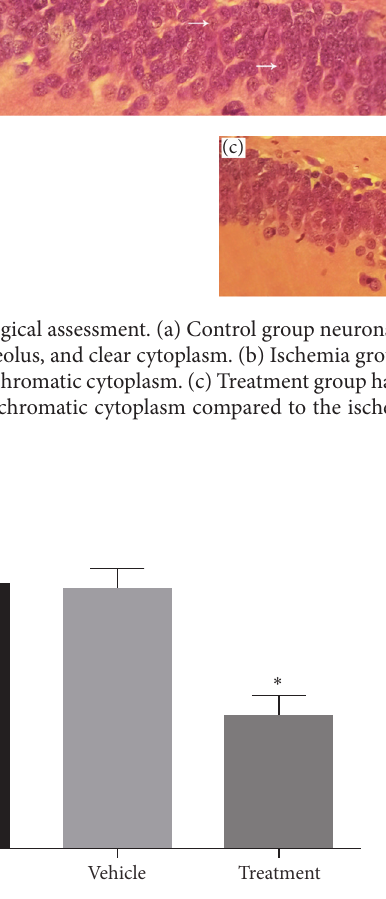
Figure 7: Effects of bone marrow mesenchymal stem cells (BMSCs) on neuromuscular function in rats after cerebral ischemia. Signifi- cant difference with treatment group ( 𝑃 < 0.05 ) (shown with ∗ ).